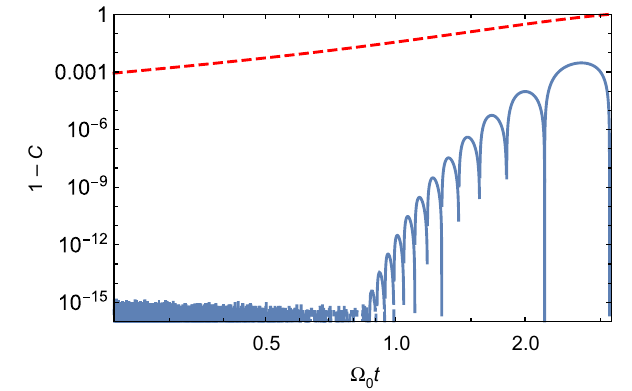
FIG. 3. Gap 1 − C between perfect coherence and that achiev- able with our truncated optimized states (solid blue curve) and coherent-state π/ 2 pulses (red dashed curve). Perfect coherence √ generation C = 1 occurs whenever (cid:3) 0 t = π/ n . At interme- diate times, a few coefficients c n are sufficient for transferring near-perfect coherence; the difference between C and 1 reaches √ 13. Coherent states with α = √ machine precision for (cid:3) 0 t ≈ π/ ¯ n , in comparison, have failure rates that only scale with 1 /α 2 (i.e., with t 2 ). All scales are